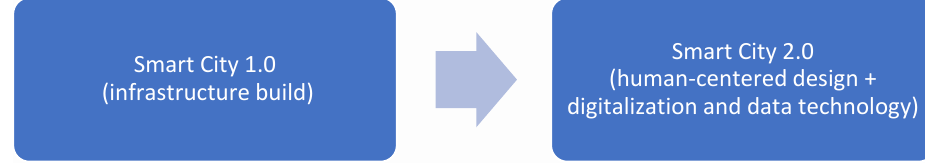
Figure 4. Smart city projects with focus on human-centered design. Source: made by authors